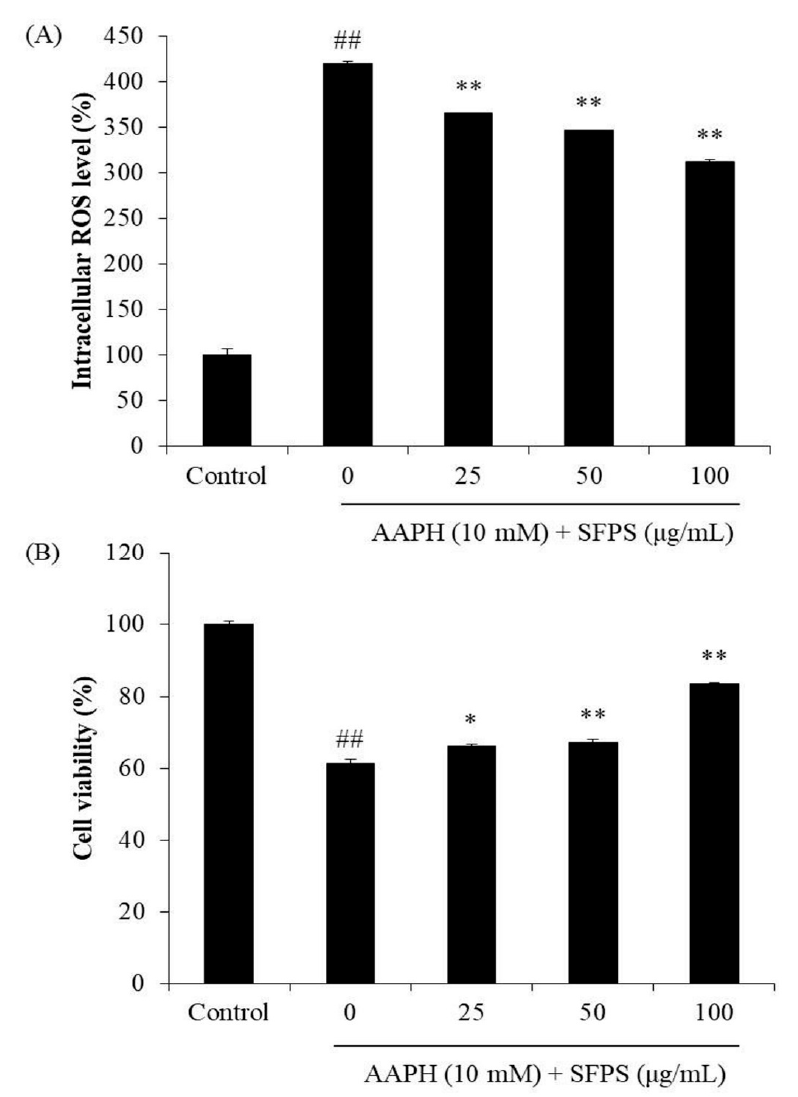
Figure 2. Protective effect of SFPS against AAPH-induced intracellular reactive oxygen species (ROS) production ( A ) and cell death ( B ) in Vero cells. Intracellular ROS level was measured by 2,7-dichlorofluorescein diacetate (DCFH-DA) assay, and cell viability was determined by MTT assay. The data are expressed as means ± standard error (SE) ( n = 3). * p < 0.05, ** p < 0.01 as compared to the AAPH-treated group and ## p < 0.01 as compared to the control